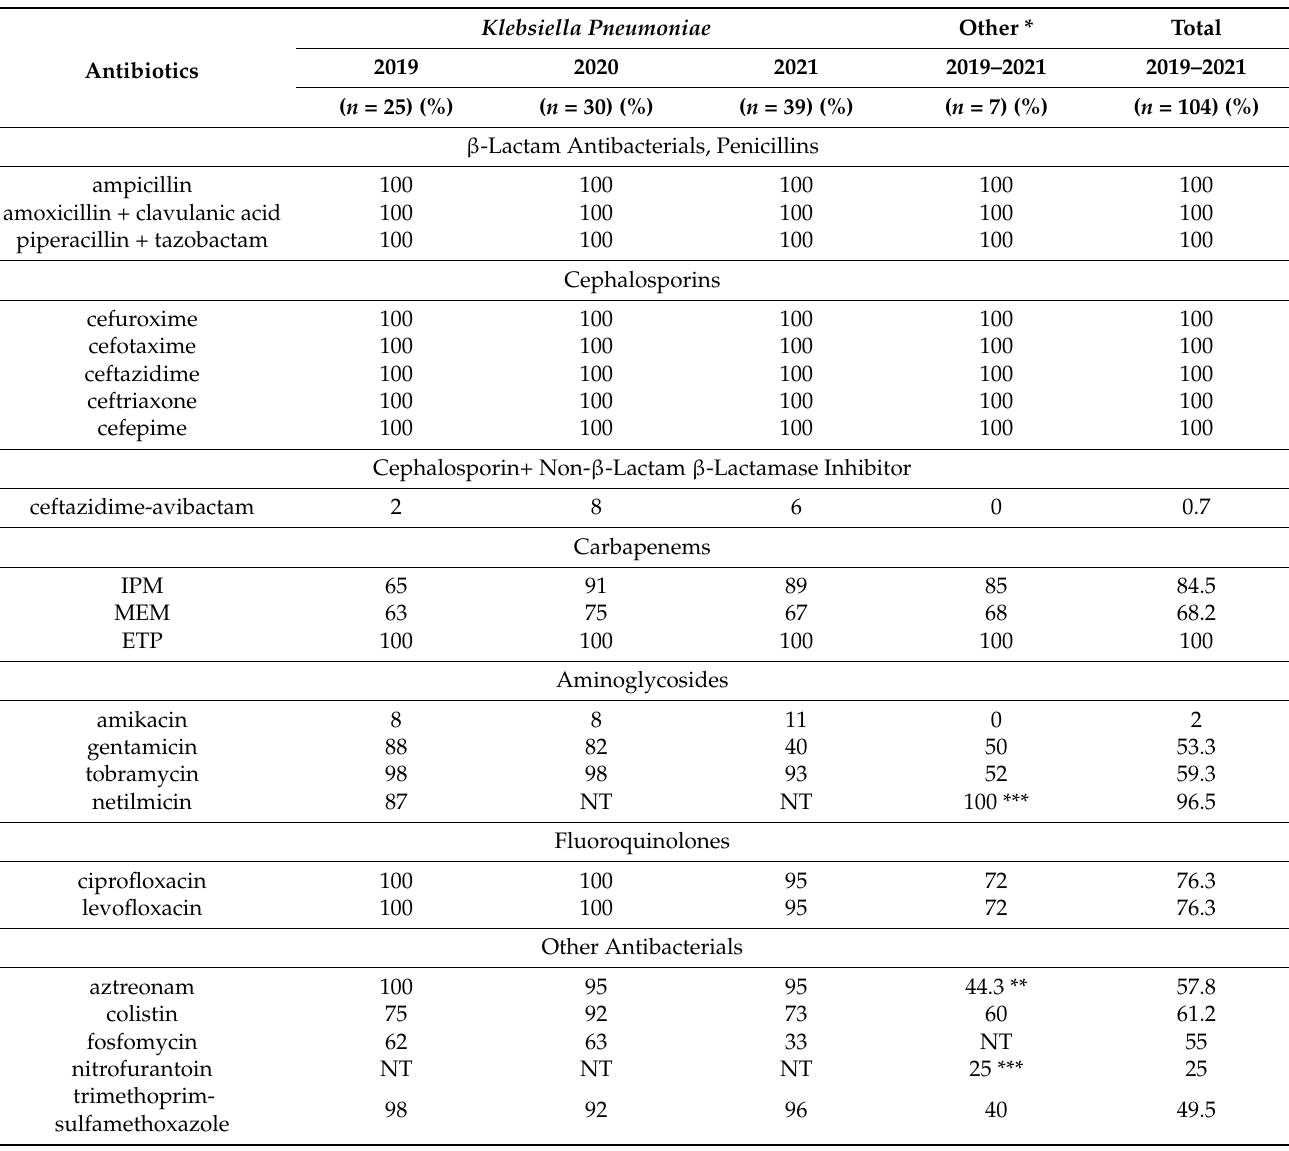
Table 5. Antimicrobial resistance of common CRE—carbapenem-resistant Enterobacteriaceae , only bacilli isolated from healthcare-associated infections. Klebsiella